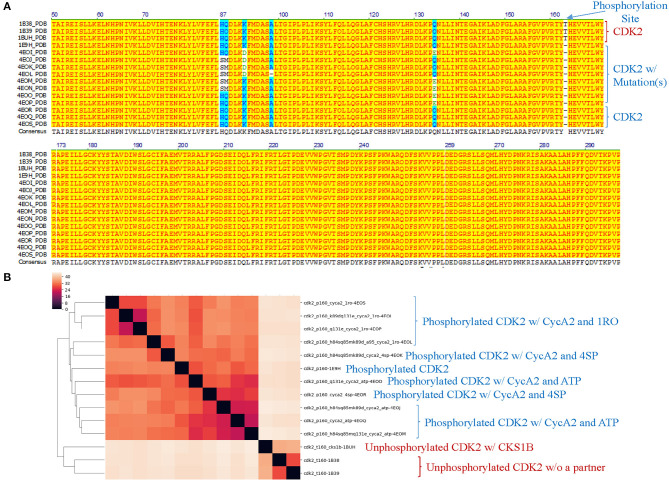
Our structure-based protein comparison method can detect conformational changes of CDK2 with the same/similar amino acid sequences due to post-translational modifications or upon binding of a ligand and a partner. (A) Fourteen CDK2 structures were found from PDB. The PDB structures were converted to amino acid sequences using pdb2fasta developed by Yang Zhang's lab. We trimmed the structures from N-terminus or C-terminus to make sure all CDK2 structures have the same amino acid sequence except mutations specified. The CDK2s with the mutations are labeled as well. The phosphorylation site at Thr160 is indicated. Note: phosphorylated Thr, TPO, is not shown in the amino acid sequence alignment; (B) The CDK2 structures are clustered using our method. p160 represents phosphorylation at Thr160 and t160 means Thr at the position of 160 (unphosphorylated). The CDK2 interacting proteins: cks1b and cyca2 are indicated. aa1xx(x)aa2 means aa1 at position of xx(x) was mutated to aa2, e.g., k89d means lysine at position 89 was mutated to aspartate. a95 indicates a deletion of alanine at position 95. Three ligands, ATP, 4SP, and 1RO, are labeled. a-b, Unphosphorylated CDK2 sequences are labeled in brown and phosphorylated CDK2s are labeled in blue.